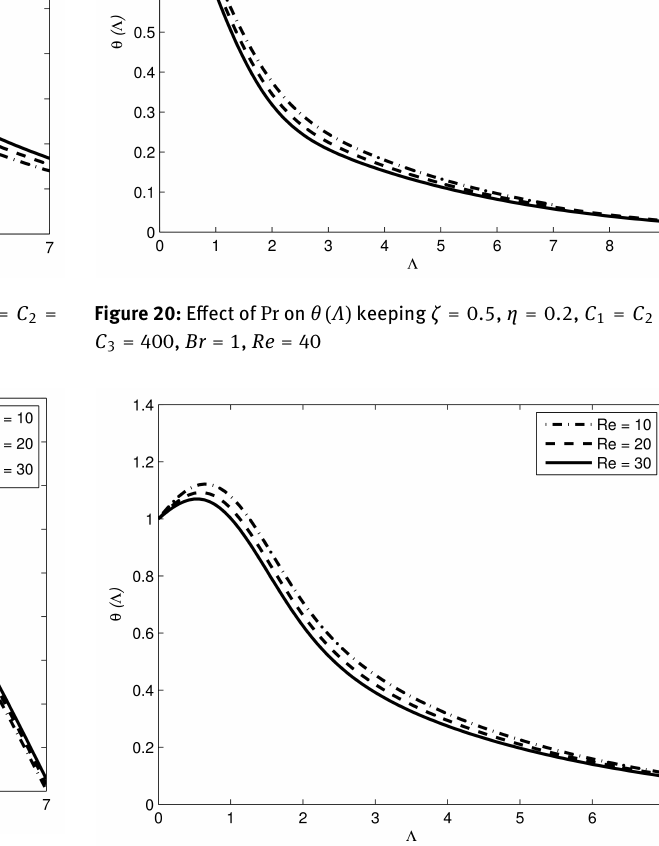
Figure 21: Effect of Re on θ ( Λ ) keeping ζ = 0.5 , η = 0.2 , C 1 = C 2 = C 3 = 50 , Br = 5 , Pr = 6.8